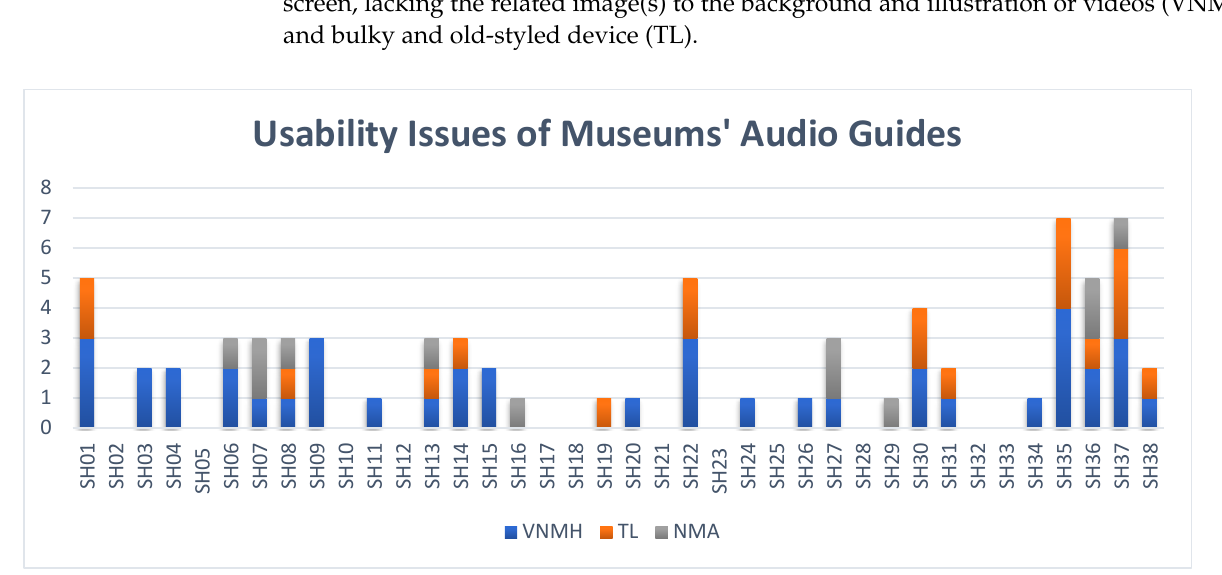
Figure 4. Usability issues of audio guides of 3 museums surveyed.